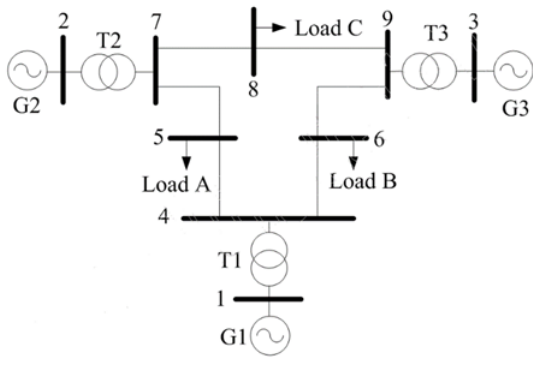
Figure 4. WSCC 9 bus test system.